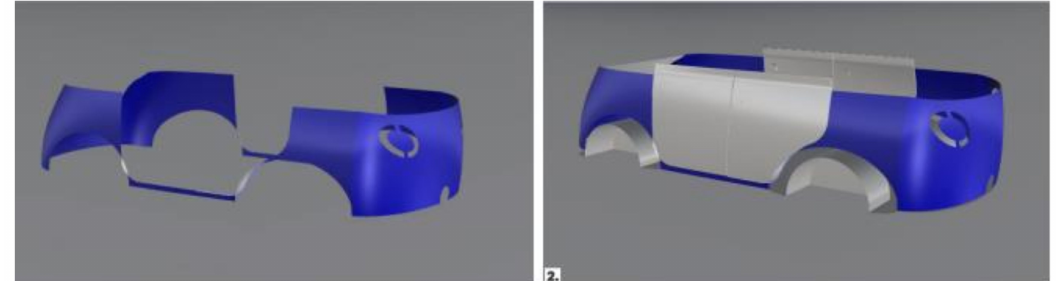
Figure 26. New FIAT 600 Omega—CAD 3D model: body side